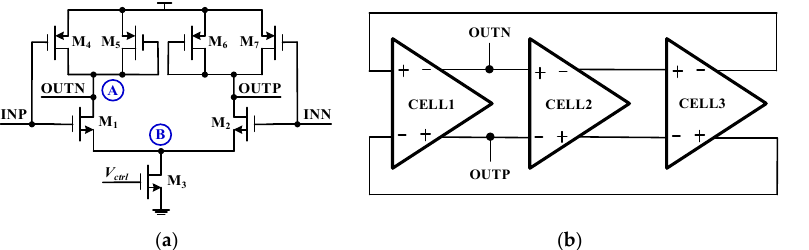
Figure 2. SET circuit-level simulation for different nodes and delay cells of the VCO. ( a ) Different nodes. ( b ) Different delay cells.